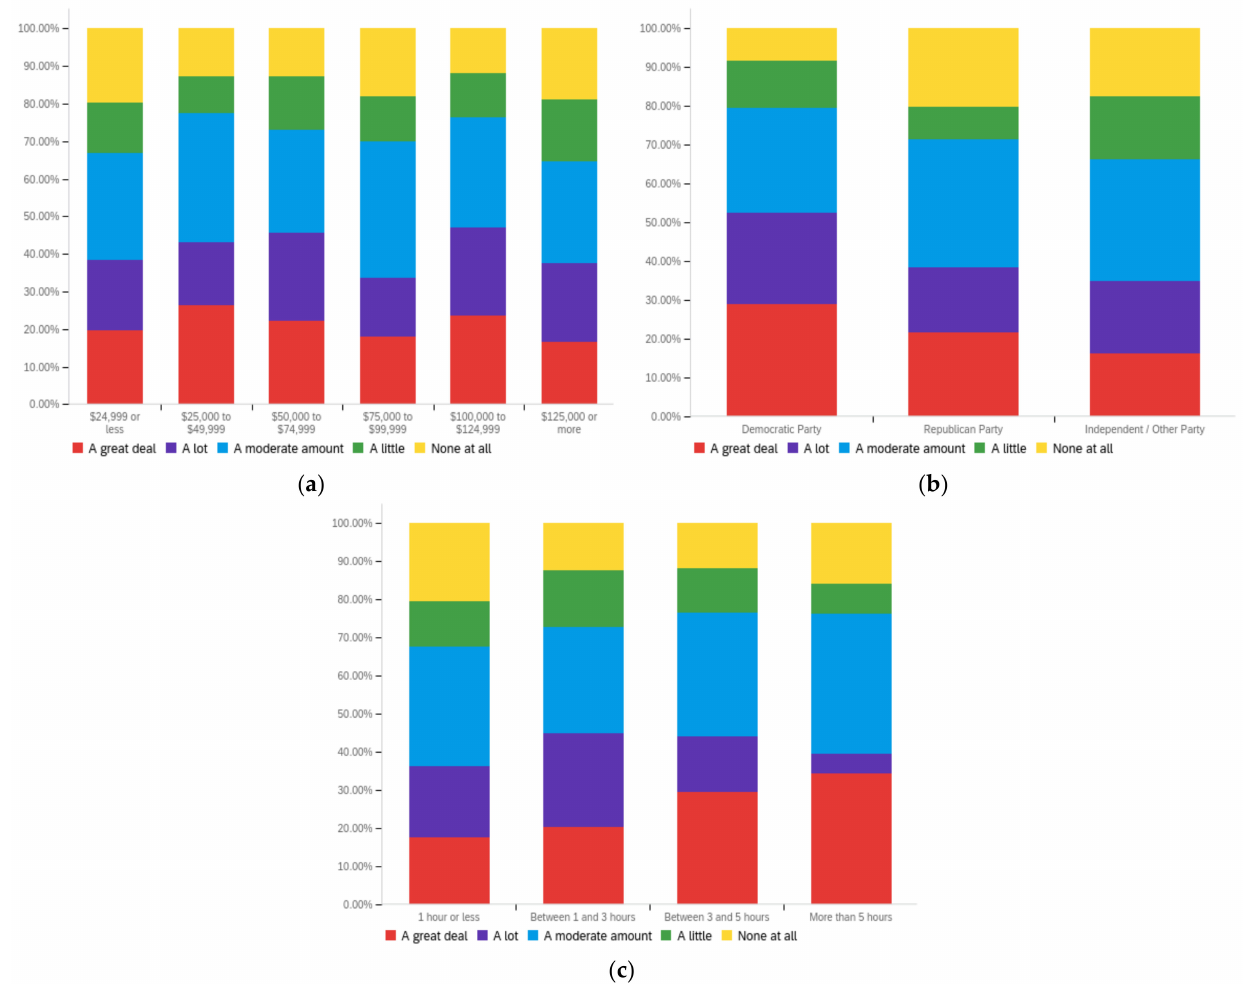
Figure A15. Article sponsor—ideal perception impact by: ( a ) income level (top left), ( b ) political affiliation (top right) and ( c ) online usage (bottom).